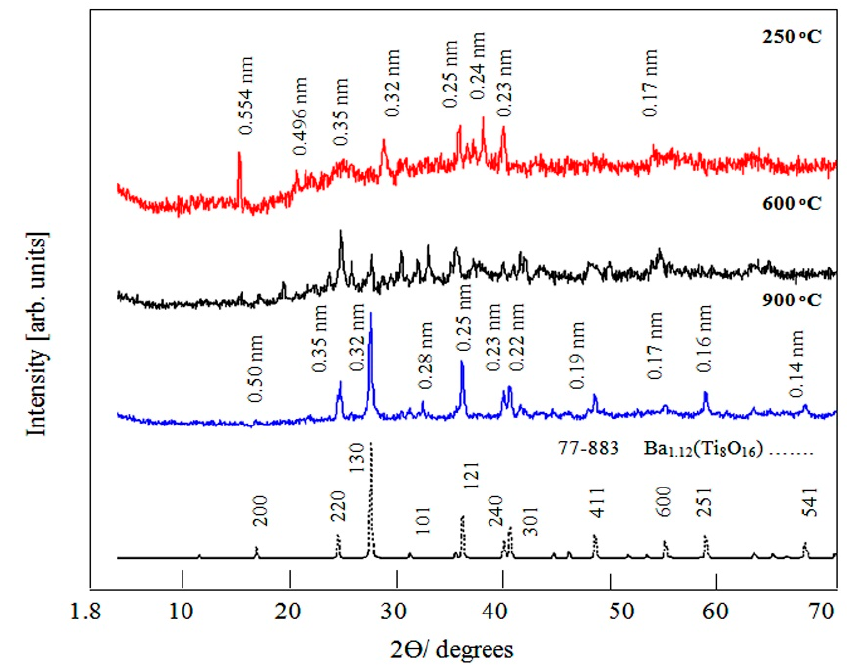
Figure 1. XRD patterns of BT1 at different temperatures. The basic formula of hollandite is AB 8 O 16 , with the A-site often occupied by larger mono-and/or divalent cations and the B-site by smaller tri-and/or tetravalent cations. The formation of the hollandite phase resulted from a framework composed of BO 6 octahedra with tunnels along the C-axis in which the larger A-cations are located. Due to the barium deficiency in the stoichiometry, barium titanium hollandite is formed. The symmetry of the crystal structure of Ba 1.12 (Ti 8 O 16 ) can be tetragonal. Therefore, the crystal structure consists of octahedra of TiO 6 , and partially occupied Ba-cations on the tunnel sites. Barium hollandites may exhibit long-range ordering of barium cations and vacancies in the tunnels and have the possibility to be commensurate [30]. In addition, the diffraction peaks with remarkable broadening revealed the crys- tallinity in the nanoscale regime of the sample of BT1-900 particles. Therefore, the crys- talline size was calculated using the Debye–Scherer